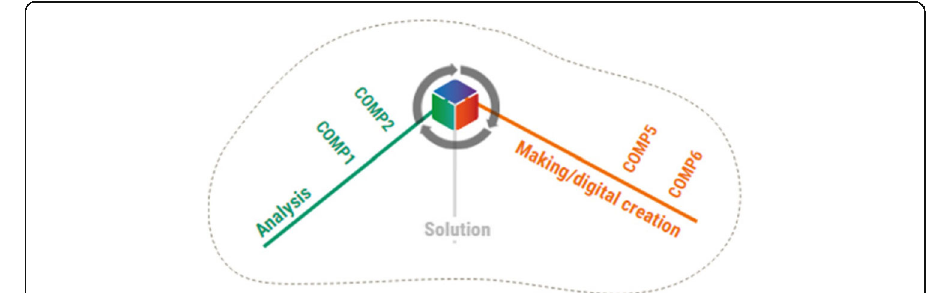
Fig. 3 Four components of the CT competency related to CPS of PISA